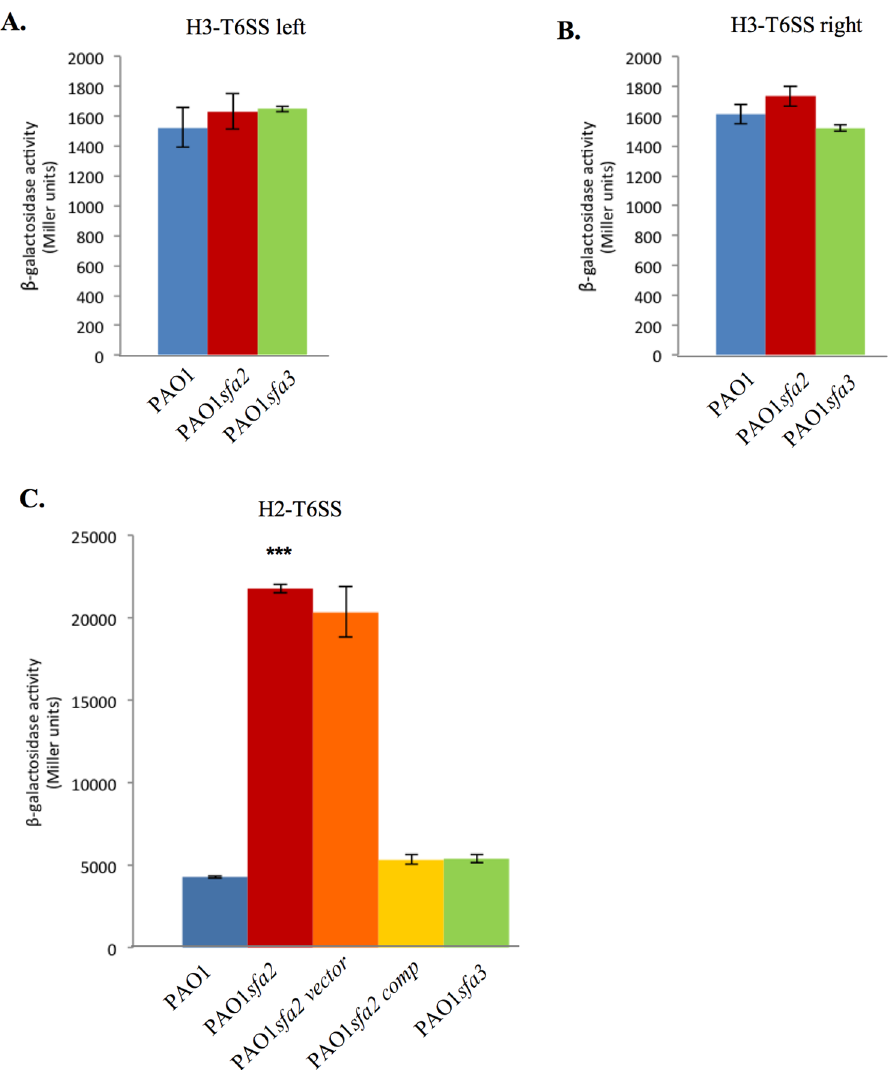
Figure 5. Sfa2 negatively controls H2-T6SS expression while H3-T6SS expression is Sfa-independent. The expression of H3-T6SS left (A) , H3-T6SS right (B) , and H2-T6SS (C) after 6 hours of growth after 9 hours (A & B) or 7 hours (C) at 37 u C in the WT strain (blue bars), in a PAO1 sfa2 mutant (red bars), and in a PAO1 sfa3 mutant (green bars). Expression is given in Miller units. Each experiment was done in triplicate and independently repeated three times; error bars indicate the standard